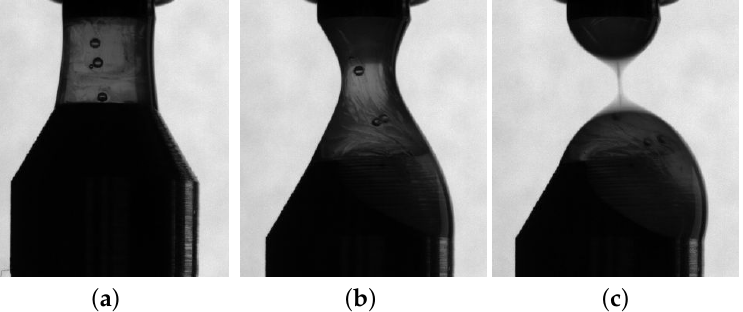
Figure 5. The nematic bridge of ST00552, 17 s before pinch-off ( a ), 0.25 s before pinch-off ( b ) and less than 10 ms before pinch-off ( c ), ( α = 1.73). The nematic material started to wet the hull approximately 40 s after the start of the experiment in µ g , which led to the instability of the cylinder radius and the premature pinch-off. The image sizes are 8 mm × 9